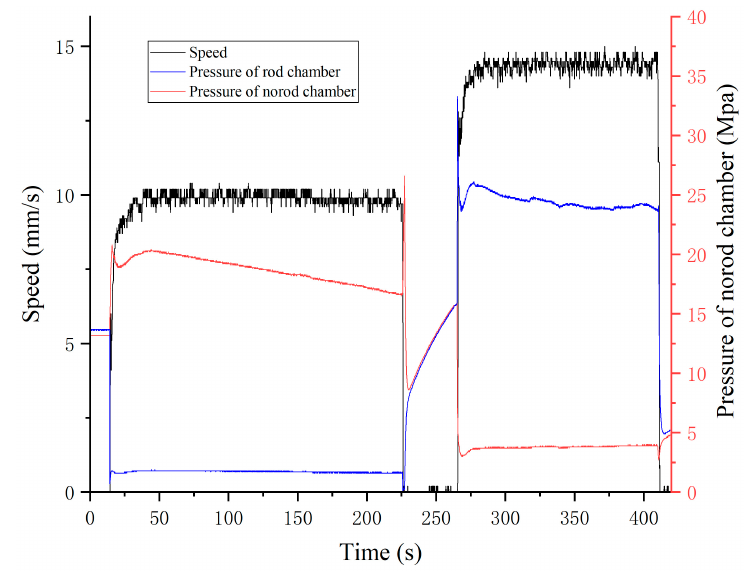
Figure 16. Step response experiment results of cylinder #1 using FLADRC.